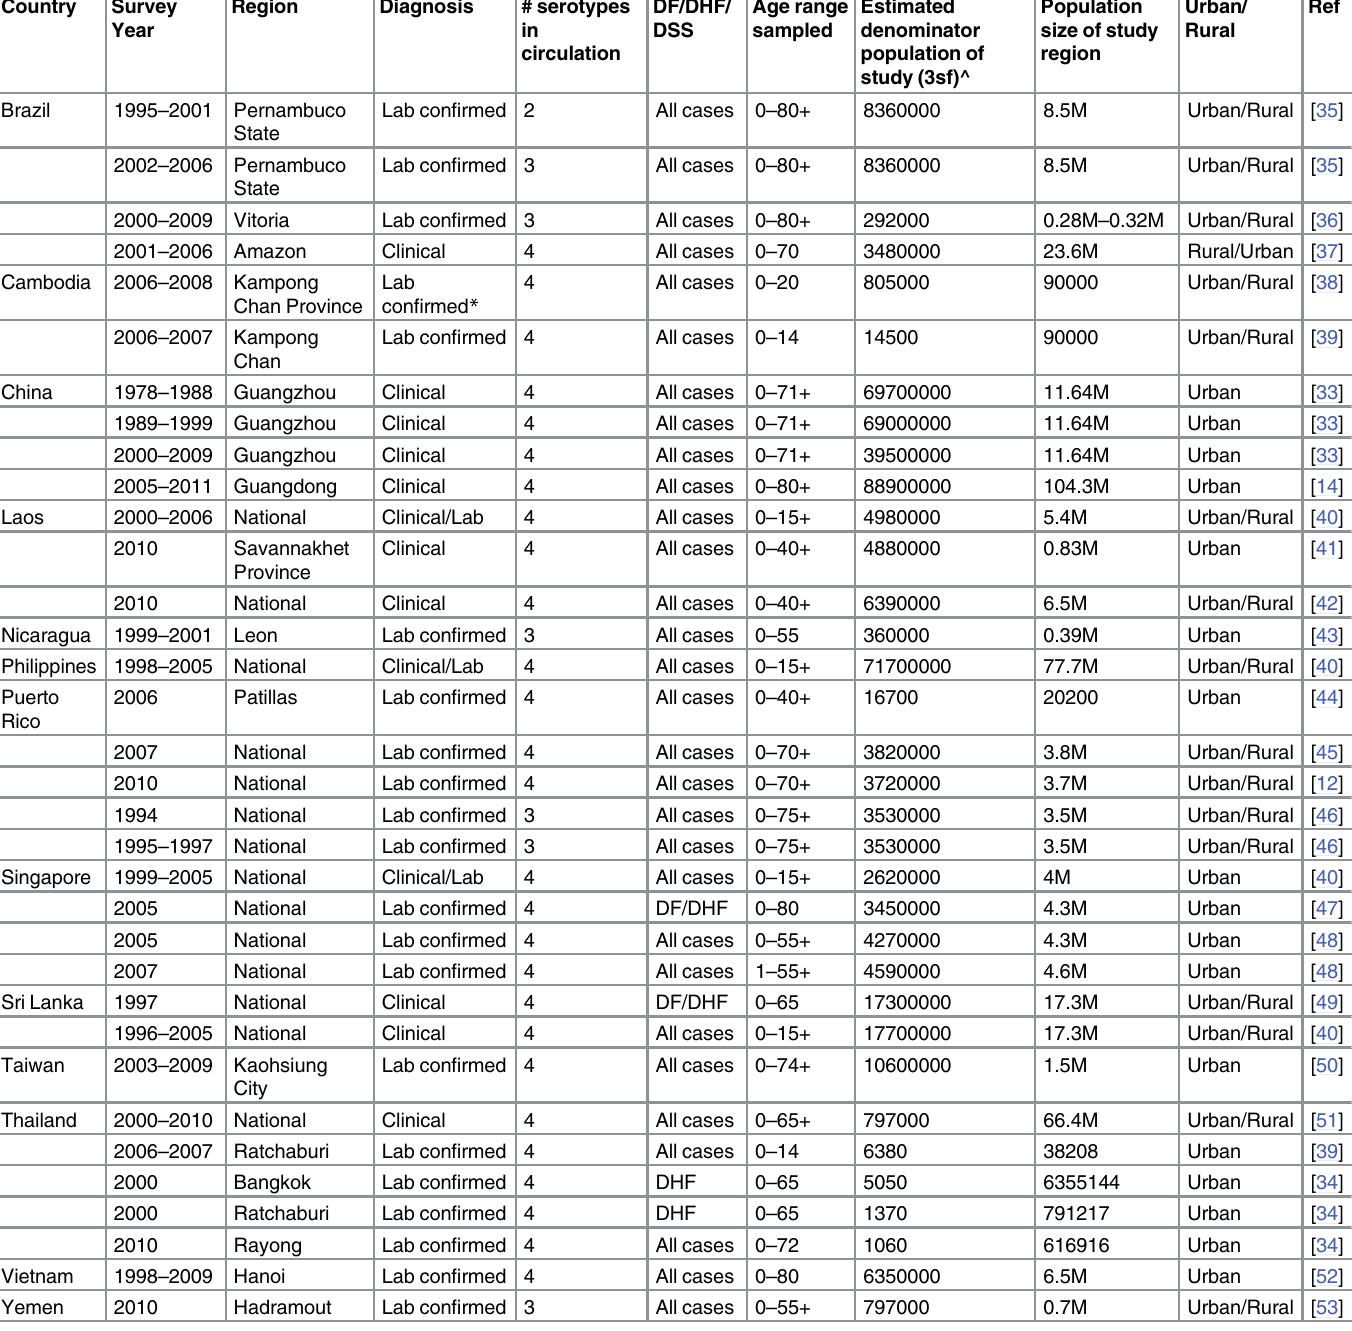
Table 1. Summary of cross-sectional incidence datasets identified and associated